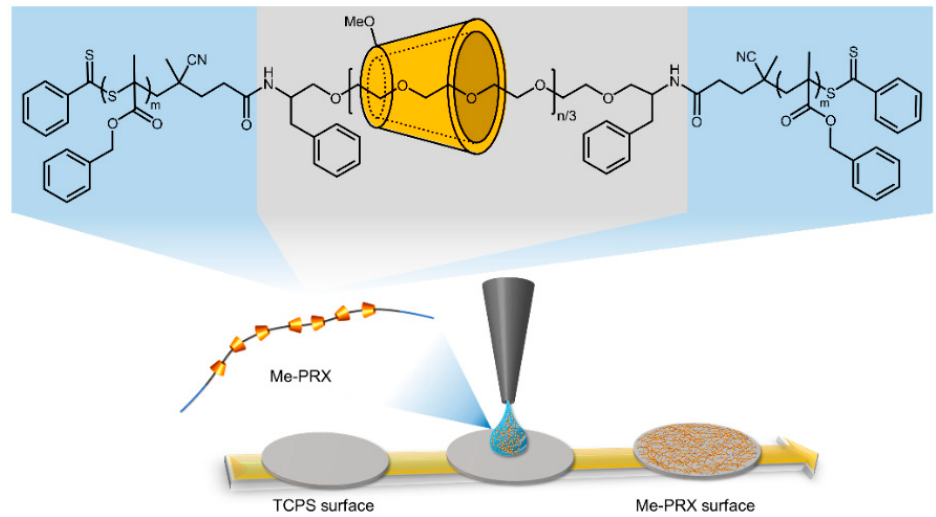
Figure 1. Chemical structure of methylated polyrotaxane triblock copolymer (Me-PRX) and preparation of Me-PRX surfaces.